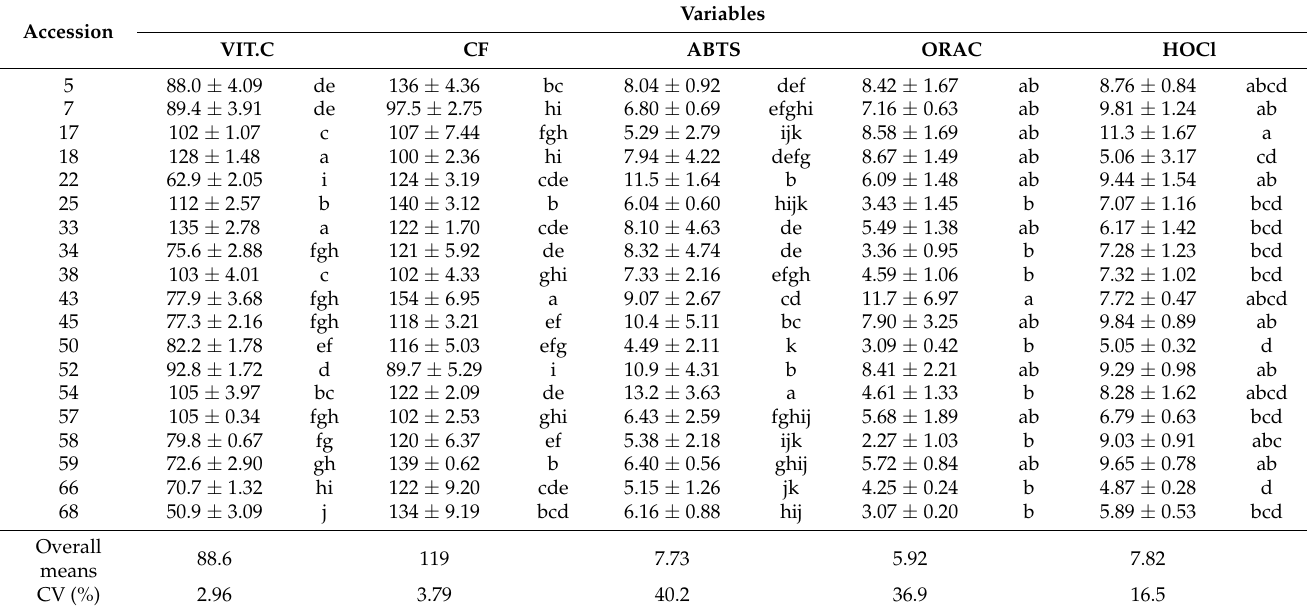
Table 2. Vitamin C and phenolic compound contents and antioxidant activity of the 19 uvaia accessions investigated in the present study.